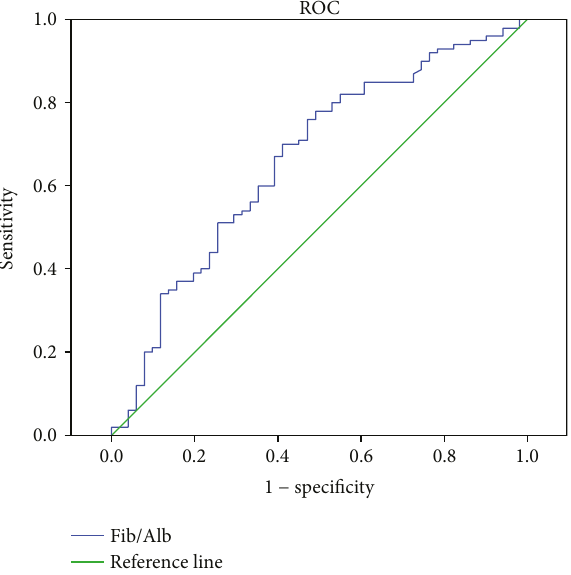
Figure 1: Determination of the cuto ff value for the Fib/Alb ratio